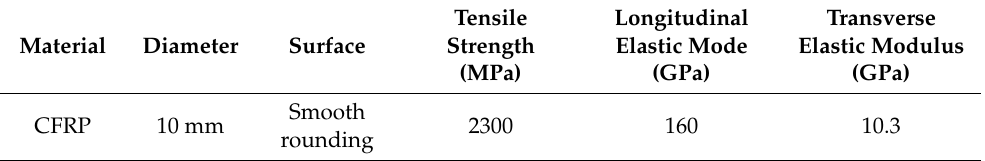
Table 1. Material parameters of CFRP tendons.